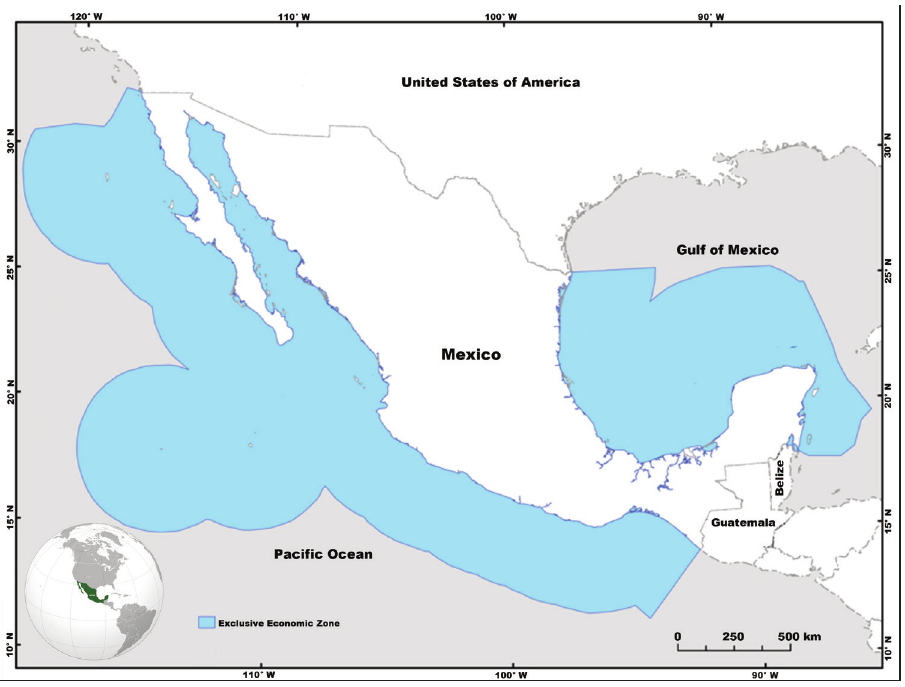
Figure 1. Map showing the Exclusive Economic Zone (EEZ) of Mexico. The zone comprises, including islands and territorial sea, approximately 3,150,000 km 2 . Modified from CONABIO (2011), available at: